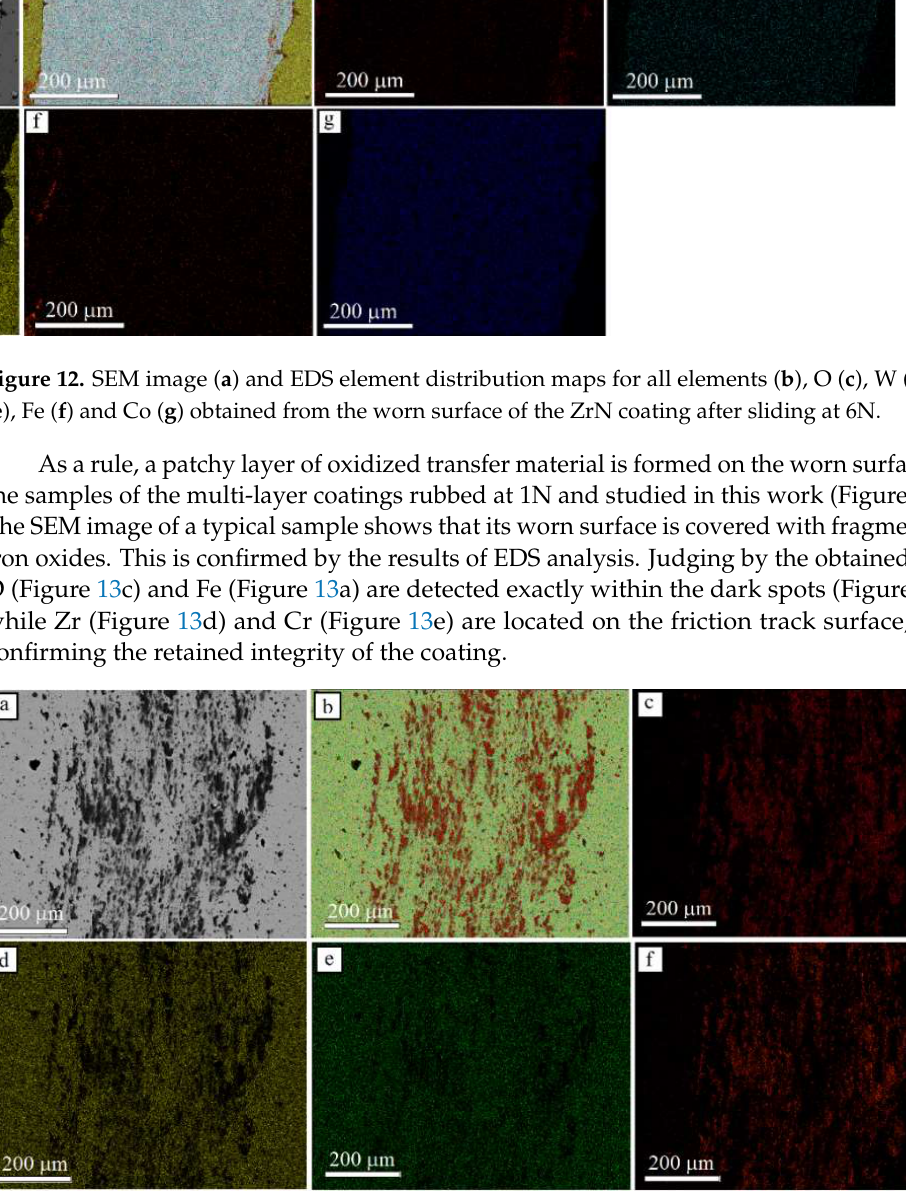
Figure 14. SEM image ( a ) and EDS element distribution maps for all elements ( b ), O ( c ), Zr ( d ), Cr ( e ) and Fe ( f ) obtained from the worn surface of the ZrCrN(5) coating after sliding at 6N. To identify the oxides formed on the surface of the samples with coatings after test- ing, X-ray diffraction analysis was carried out (Figure 15). Samples obtained after sliding at 6N will be further considered here as typical examples. When reconstructing the dif- fractograms, the logarithmic scale of the reflection intensity axis was used for better iden- tification of the phases. All the diffraction patterns clearly show WC reflections, which may originate from the WC-Co substrate. When examining a sample coated with ZrN, Co reflections were also detected due to the fact that part of the ZrN coating was removed. In other cases, the Co reflections have not been observed unless there was full deterioration